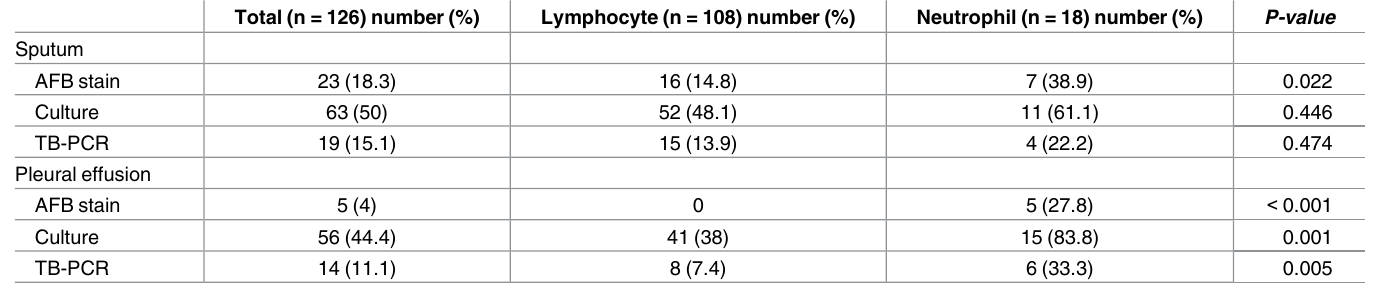
Table 4. Microbiological Characteristics of Lymphocyte- and Neutrophil-Predominant Definite Pleural TB.